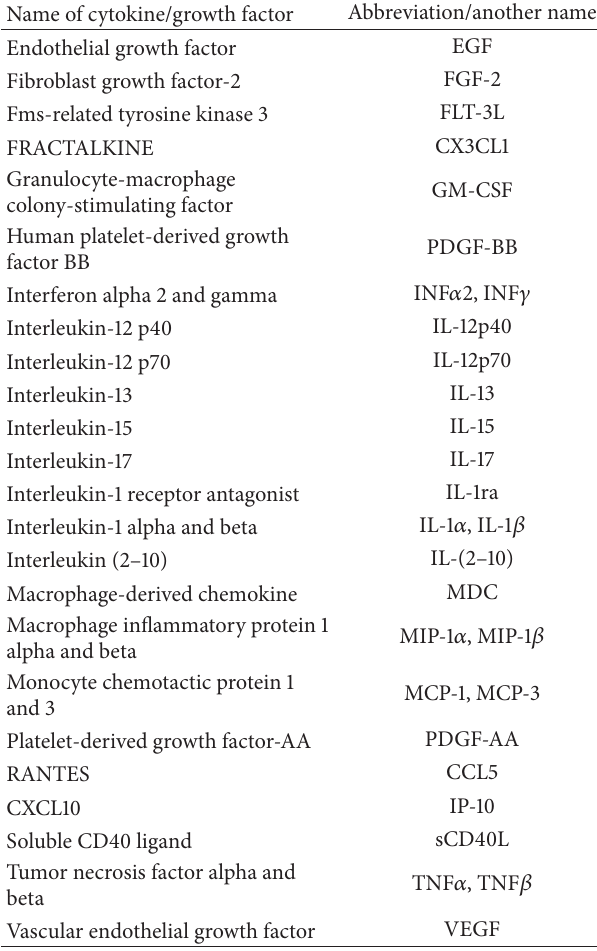
Table 1: List of cytokines and growth factors investigated by MAGPIX cytokine